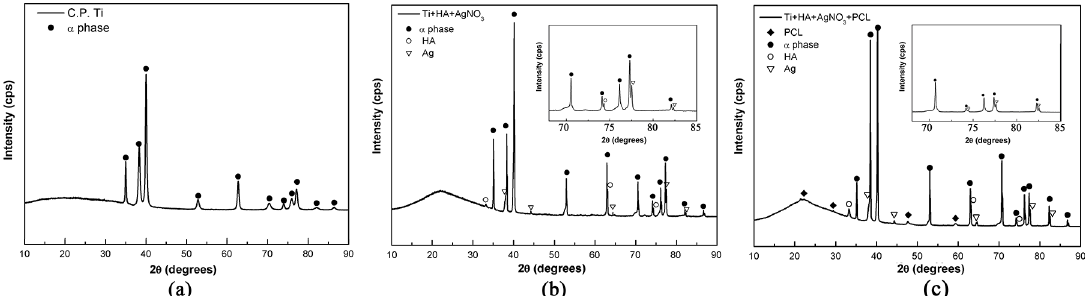
and Ti + HA + AgNO 3